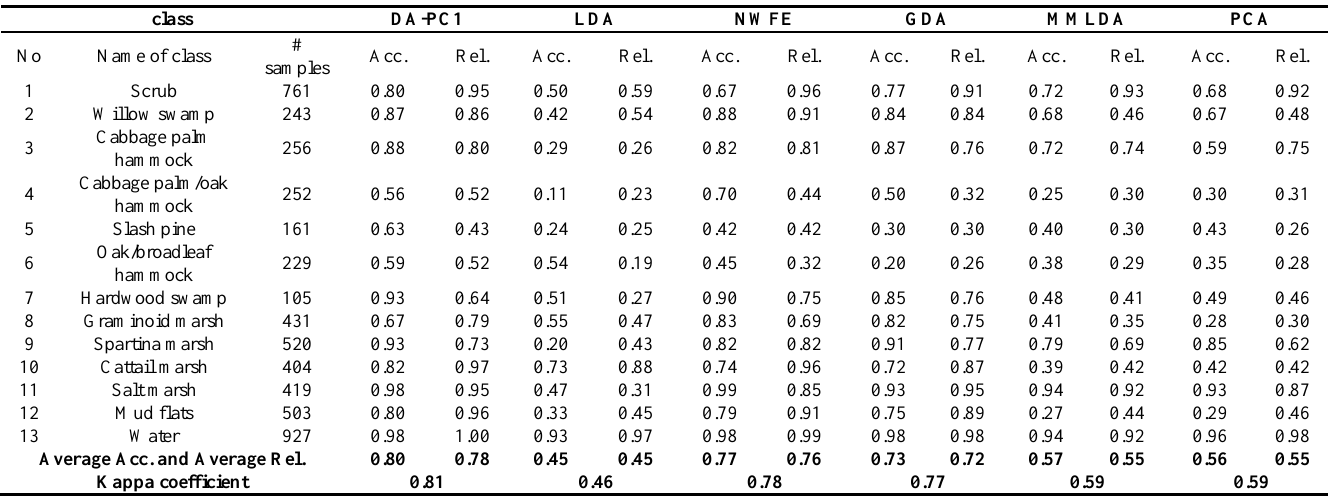
Table 2. The accuracy and reliability of classes of KSC dataset obtained by SVM classifier, 15 training samples and 8 extracted